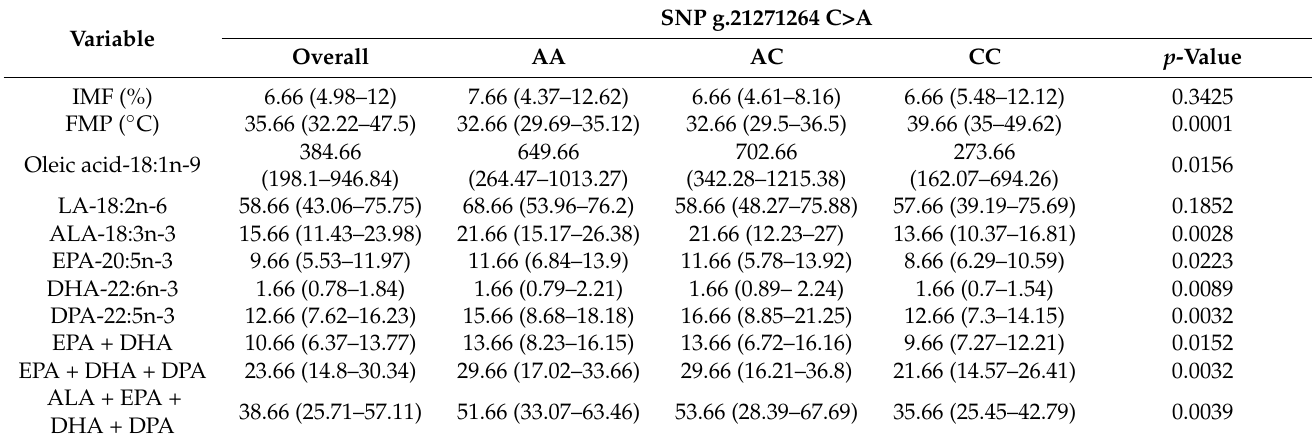
Table 6. Descriptive summaries of the associations between SCD SNP locus g.21271264 C>A and genotypes with intramuscular fat (IMF), fat melting point (FMP), and fatty acid composition in